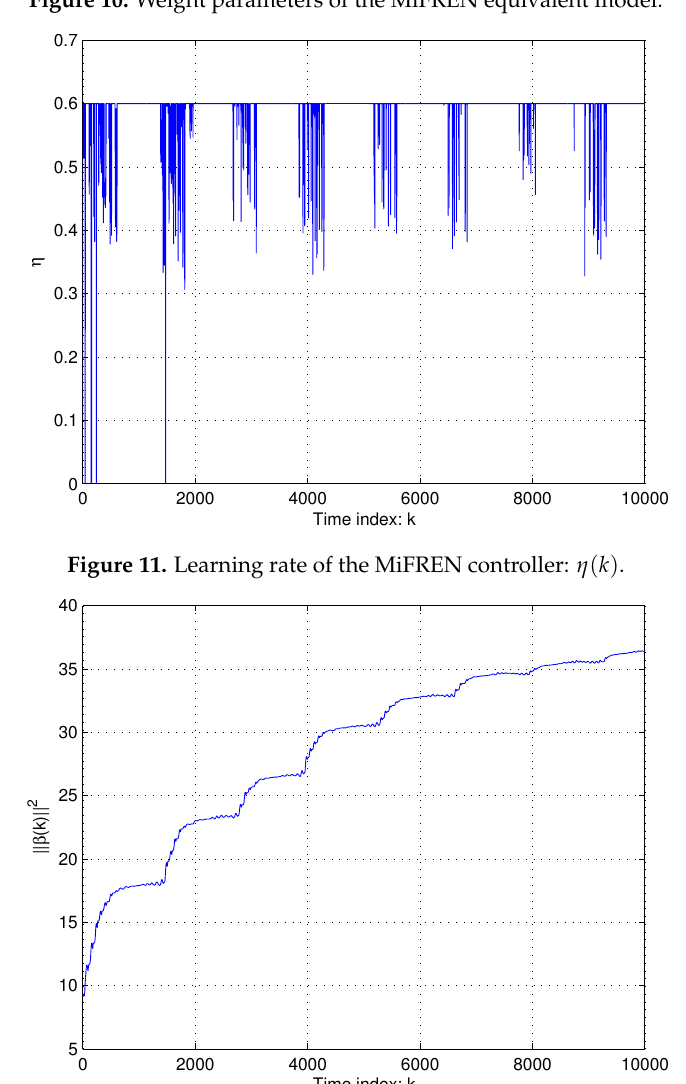
Figure 10. Weight parameters of the MiFREN equivalent model.